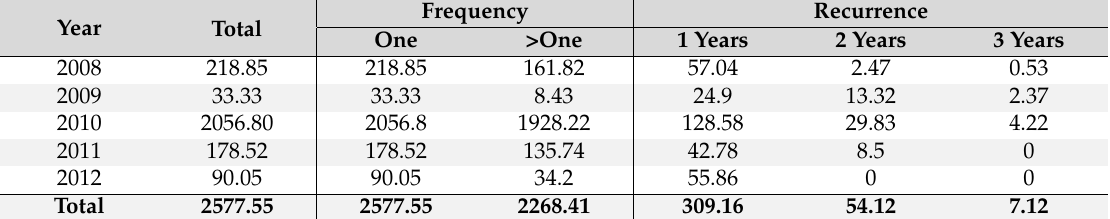
Table A3. Total burned area in hectares (km 2 ) that burned one time, more than once, and the number